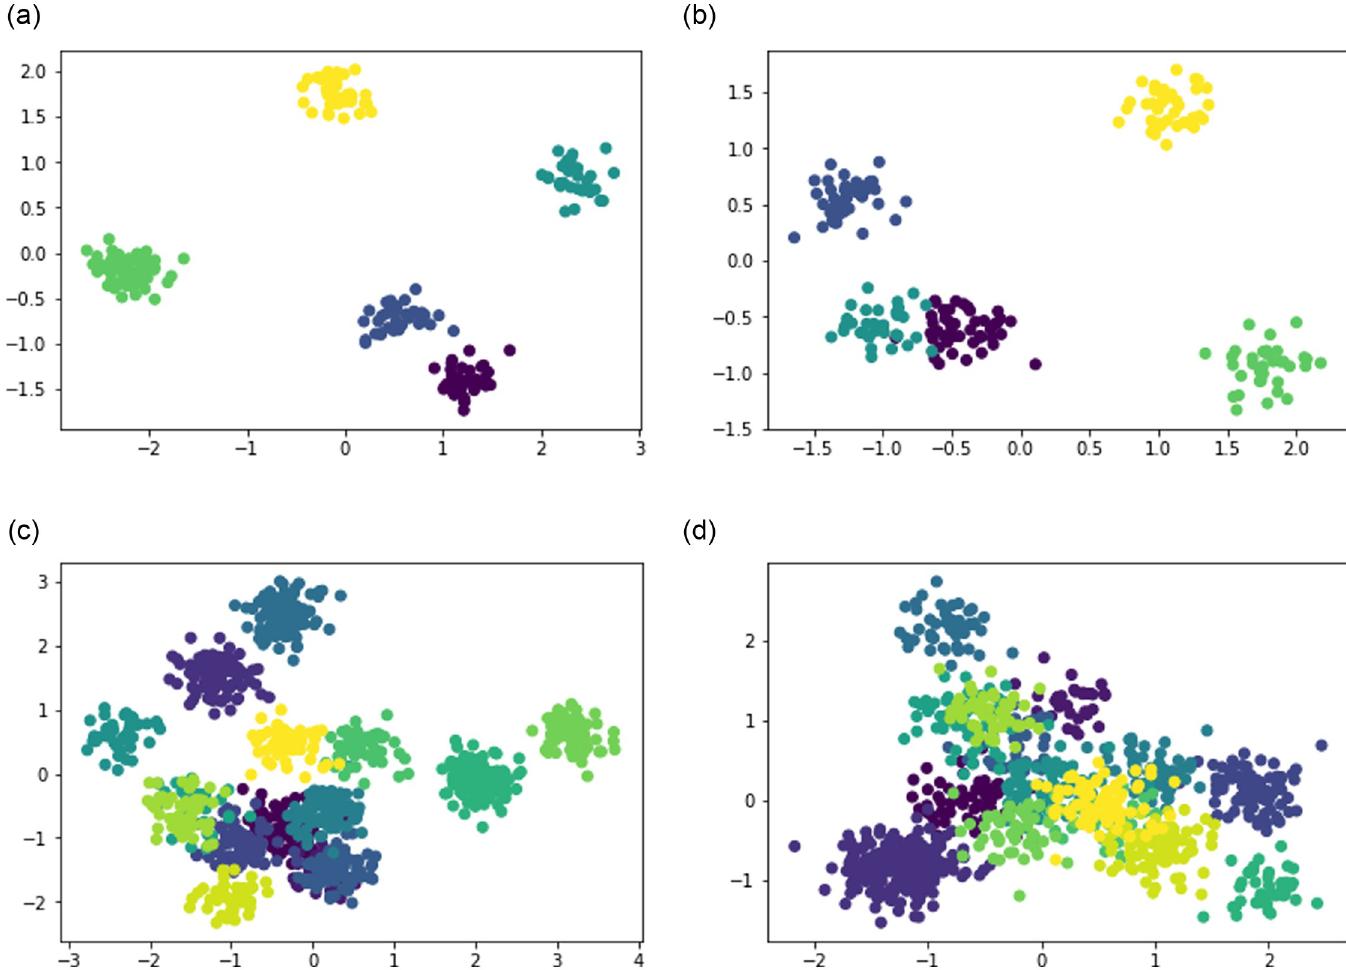
Fig 2. Samples of synthetically generated clusters at quantitative features; N is the number of nodes, K is the number of communities, and α is the parameter of cluster intermix. The parameter values are: α = 0.9, N = 200, K = 5 at (a); α = 0.7, N = 200, K = 5 at (b); α = 0.9, N = 1000, K = 15 at (c); and α = 0.7, N = 1000, K = 15 at (d).